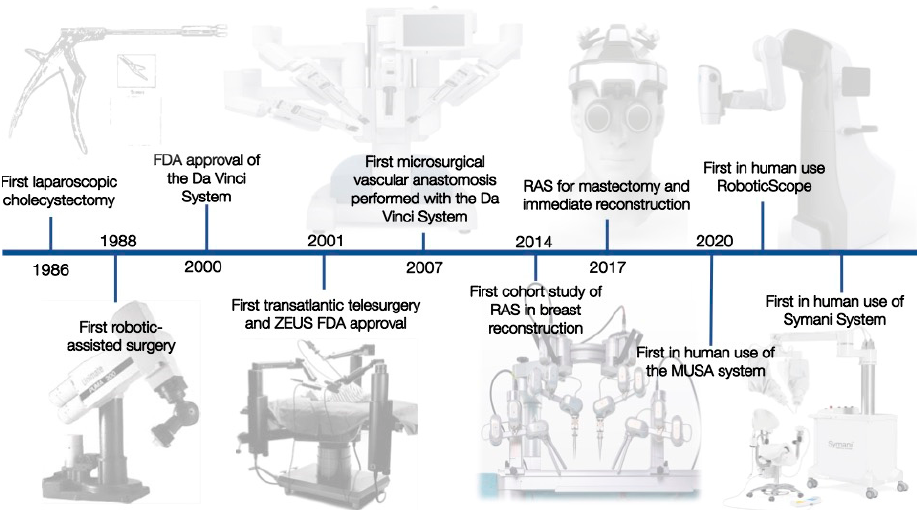
Figure 1. The most important developments in the history of RAS in plastic